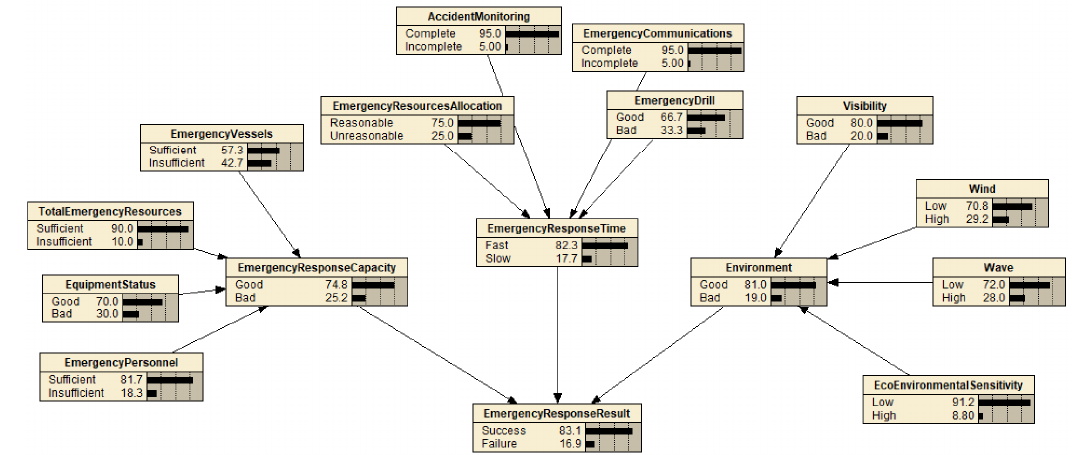
Figure 2. Result of the Bayesian network model.